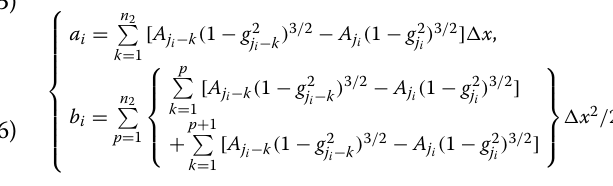
The initial reverse bending curvatures and contact angles of leveling rollers are given. The calculated results are used as inputs for iteration, until the relative error of the calculated bending curvatures and input curvatures is less than the given precision. The numerical analysis process of the leveling establishment phase is shown in Figure